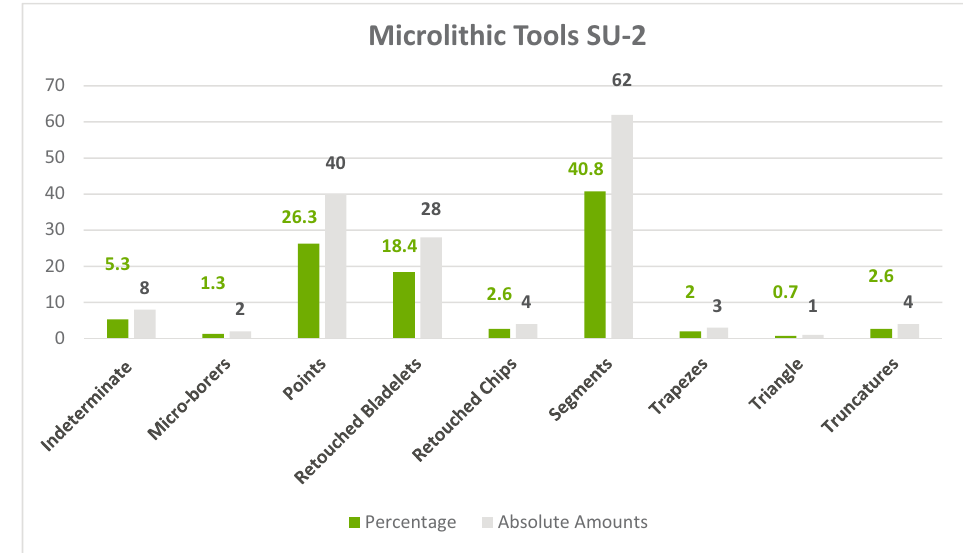
Figure 10: Microlithic tools SU - 2 ( percentage and absolute amounts )